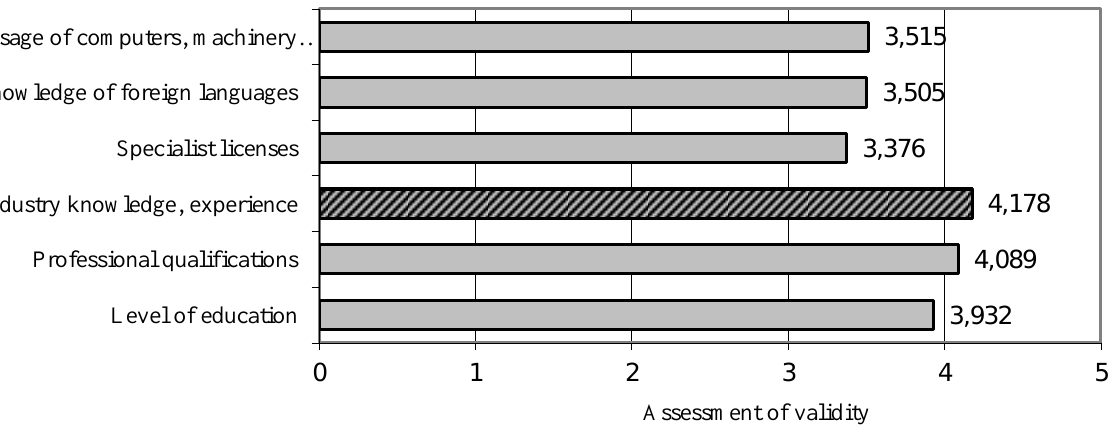
Fig. 1. The assessment of validity of hard competences when hiring employees in companies in Słupsk local labour market in 2013